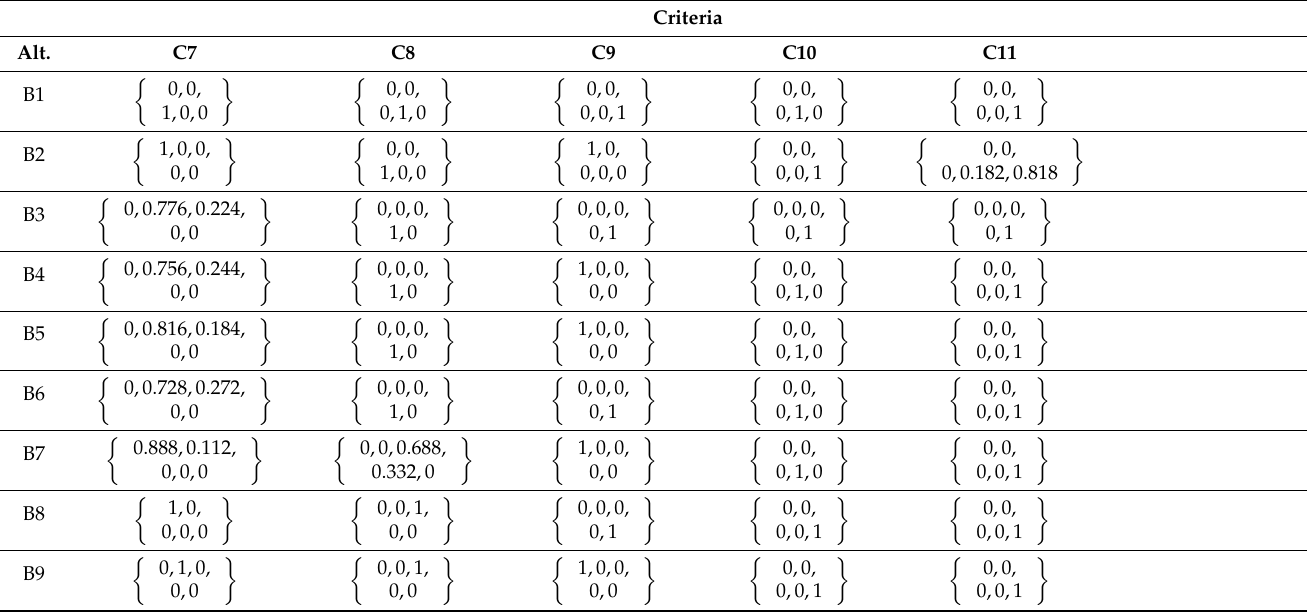
Table 5. Cont . Criteria